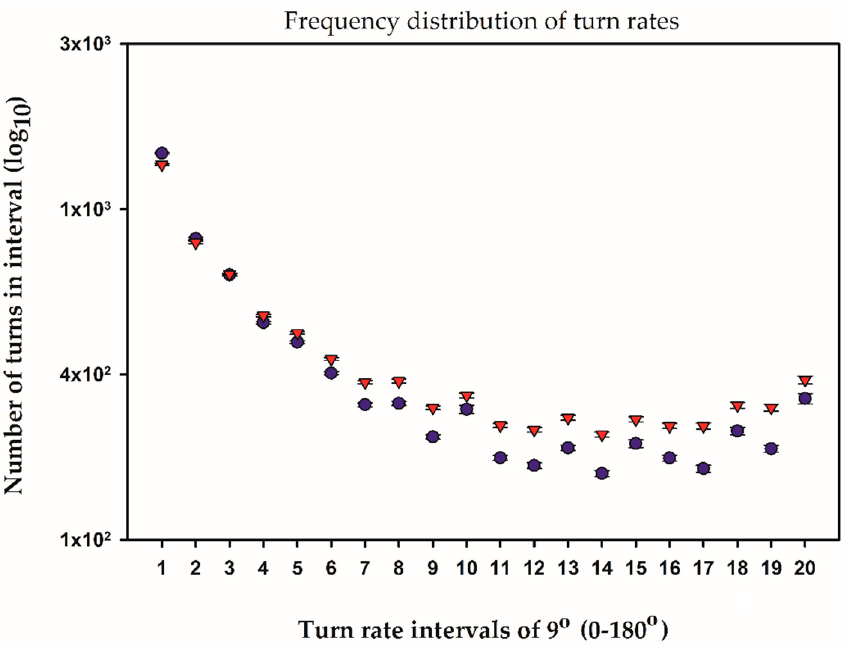
Figure 2. Velocity distribution of unexposed male zebrafish in spawning ( ▼ ) and non-spawning ( ● ) pairs during the 45 min recording. Velocities from 0 mm·s − 1 to 300 mm·s − 1 were categorized into 20 intervals of 15 mm·s − 1 . Males in spawning pairs spent less time at lower velocities and more time at higher velocities compared with males in non-spawning pairs. Note the diminutive error bars (SEM), demonstrating the uniform administration of swimming velocity among male zebrafish. Error bars represent SEM.